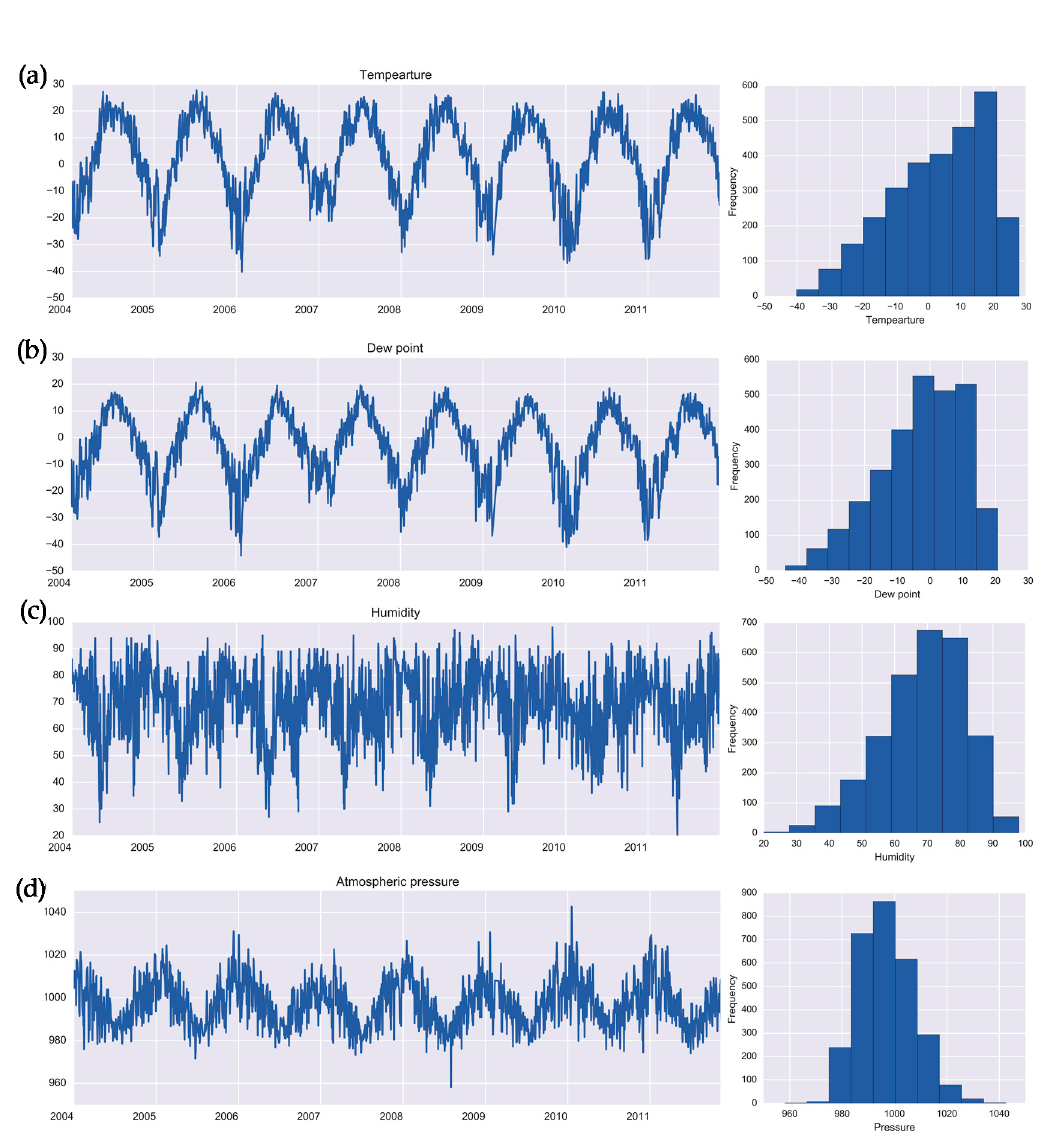
Figure 2. Daily time series and histograms for weather parameters: ( a ) temperature ( ◦ C), ( b ) dew point ( ◦ C), ( c ) relative humidity (%), and ( d ) atmospheric pressure (hPa) in Barnaul, Russia in 2004–2011.